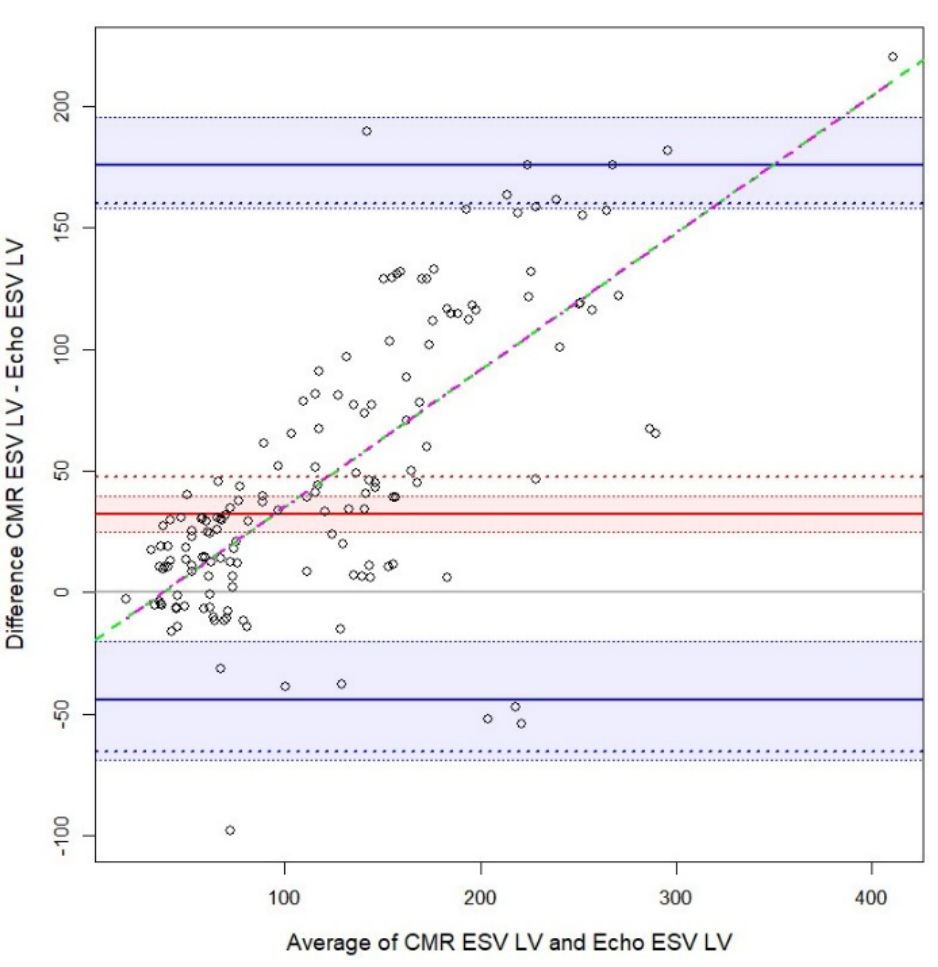
Figure 2. Bland-Altman plot for cardiac magnetic resonance imaging and cardiac echography of left ventricle end-systolic volume. CMR, cardiac magnetic resonance imaging, ESV, end-systolic volume; LV, left ventricle; continuous red line, bias as 50th quartile; dotted red line, bias as mean; red interval, 95% bootstrapped confidence interval for 50th quartile; straight blue lines, limits of agreement at 2.5th and 97.5th quartiles; blue interval, 95% bootstrapped confidence interval for limits of agreement at 2.5th and 97.5th quartiles; dotted blue lines, limits of agreement at 1.96 standard deviations from the mean; dashed green line, linear regression line; magenta dot-dashed line, general additive model fit with a spline.